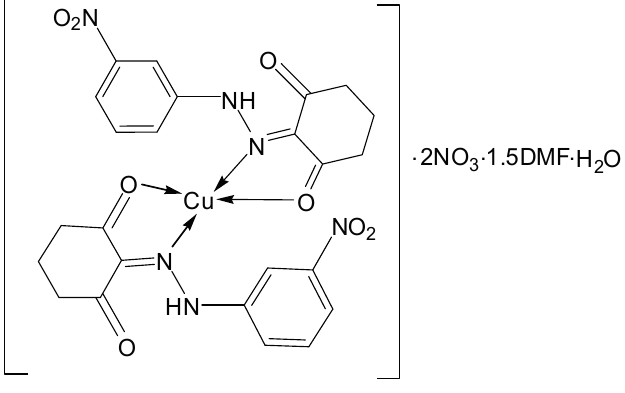
Figure 7. Structure of[Cu(L 2 ) 2 ]·2NO 3 ·1.5DMF·H 2 O